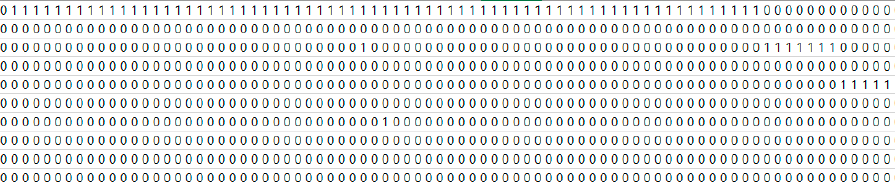
Figure 5. Powershell frequency data.